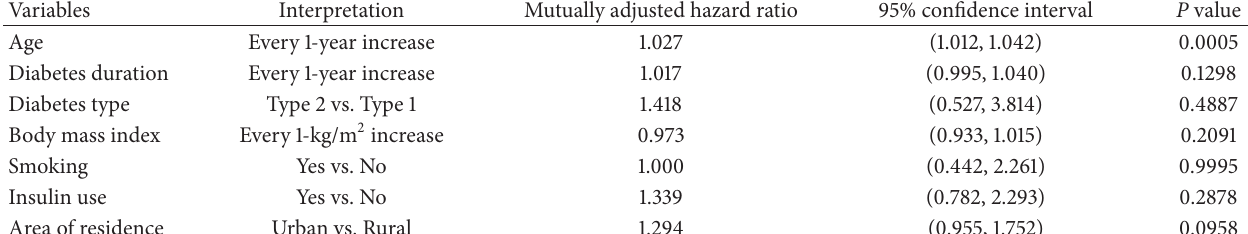
Table 2: Cox proportional hazards models showing mutually adjusted hazard ratios and their 95% confidence intervals for breast cancer mortality in women with